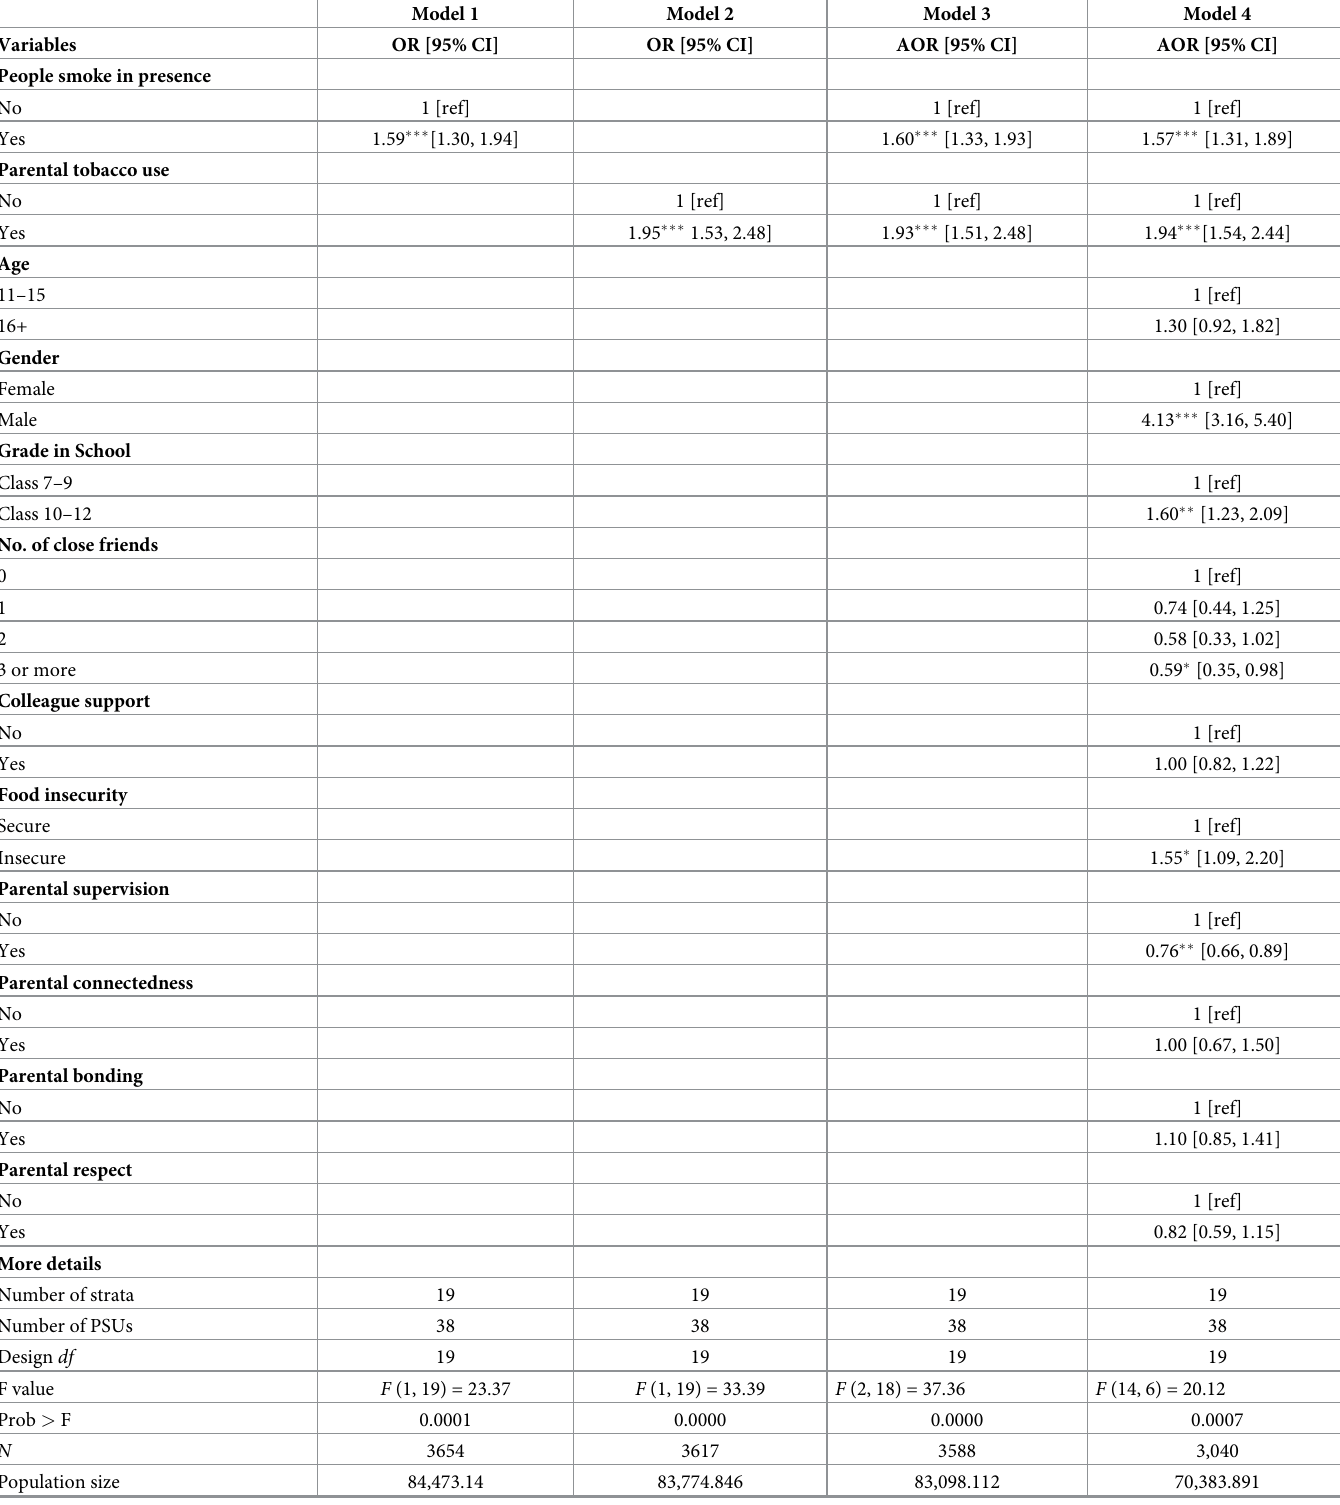
Table 3. Summary of logistic regression examining the relationship between exposure to substance and usage of substance amongst school-going